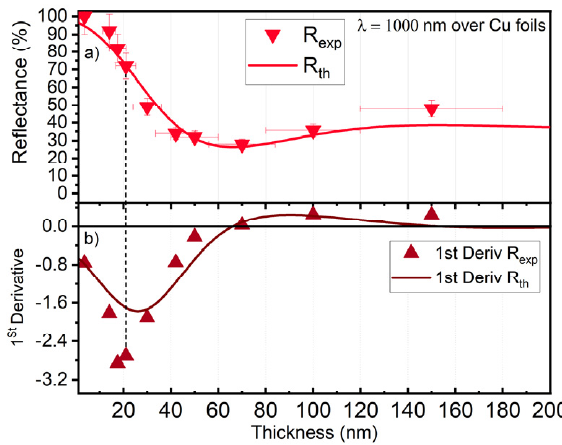
Figure 1. ( a ) Cu foils covered with a-C films xperimental (R exp ) and theoretical (R th ) reflectance for Figure 1. ( a )Cu foils covered with a-C films xperimental ( R exp ) and theoretical (R th ) reflectance for